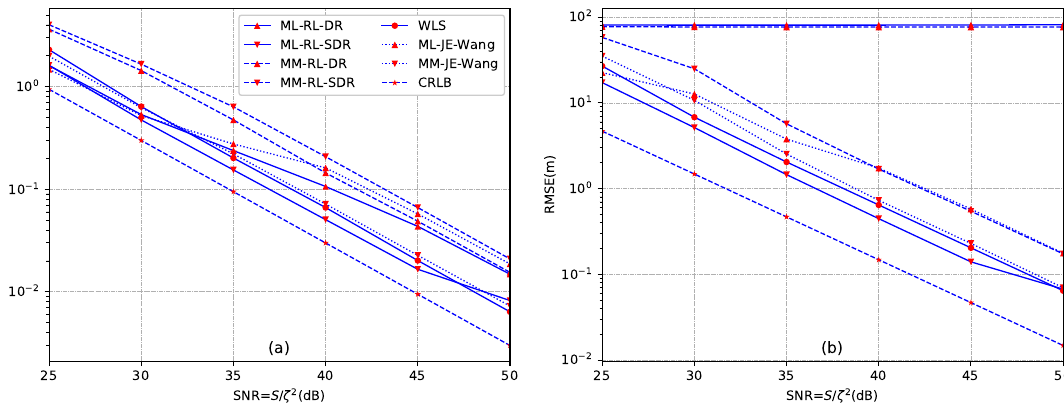
Figure 9. RMSE versus SNR. ( a ) the source is located at y = [ 10,20 ] T ; ( b ) the source is located at y = [ 100,30 ] T